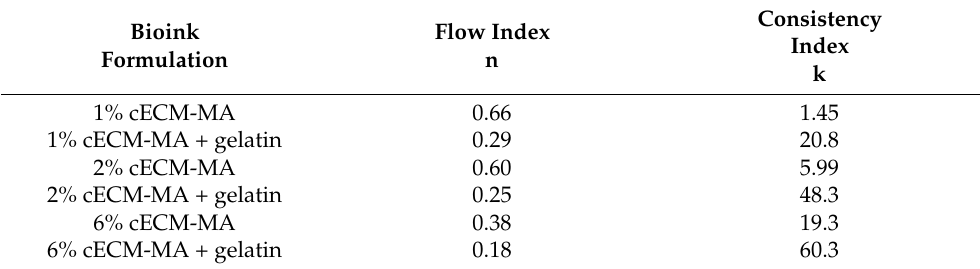
Table 1. Quantitative description of bioink rheological